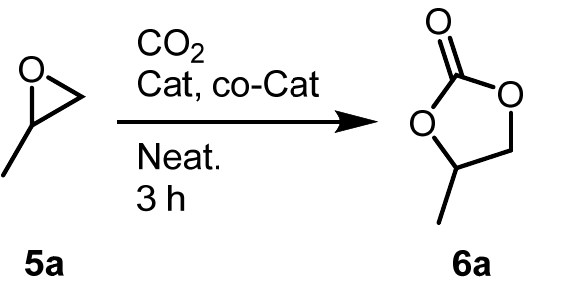
Figure 5. Cyclic carbonate synthesis using salen-Al catalysts and tetrabutylammonium halides.